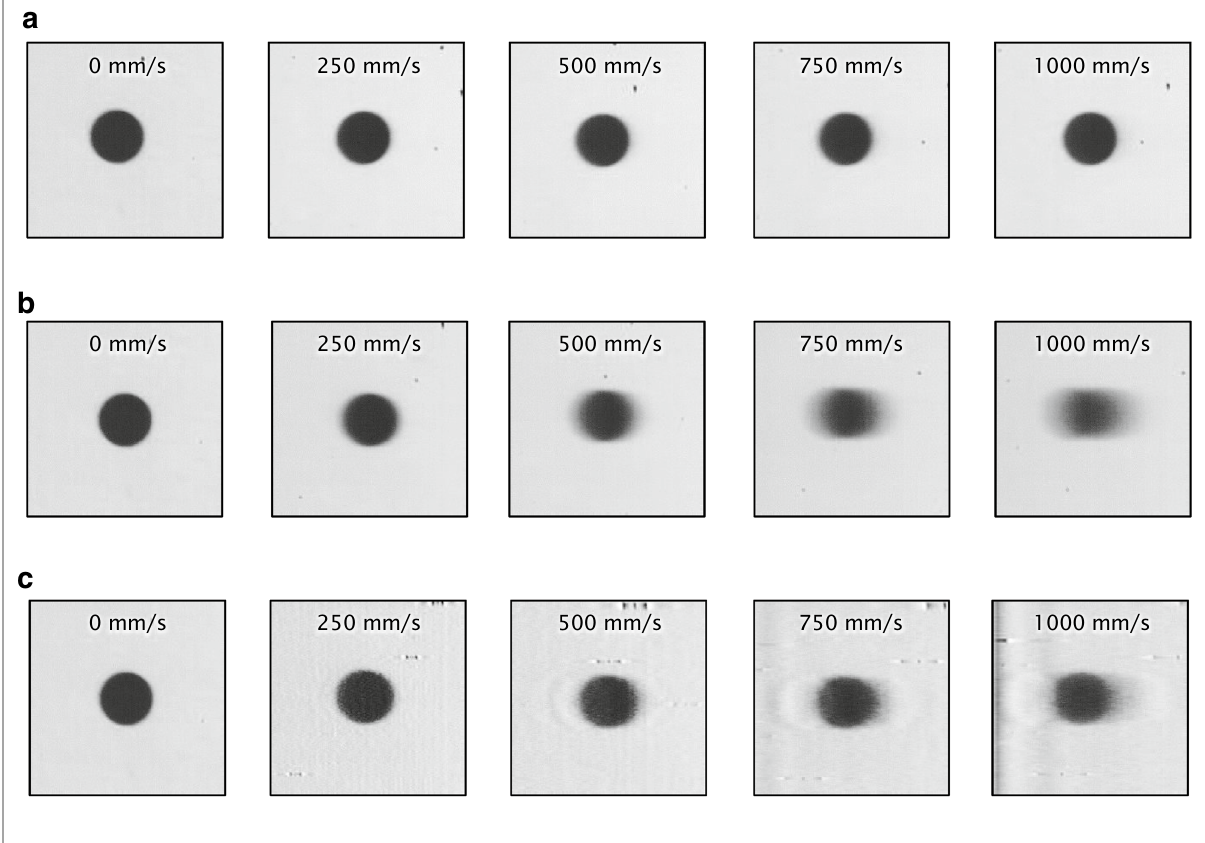
Fig. 11 Images captured when a circle dot moved in the horizontal direction. a With tracking (IT). b Without tracking (NT). c Motion deblurring (cid:31) − and represent the lengths of the major and minor axes of the approximated ellipse of the circle dot in the image.